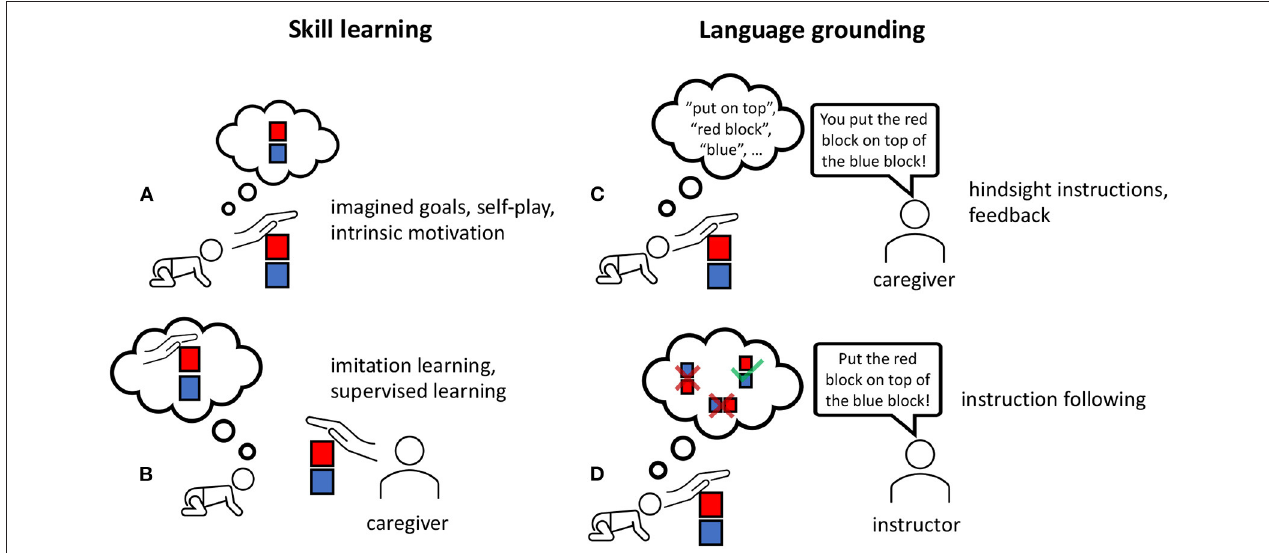
FIGURE 4 | We accentuate the learning phases of current methods (Akakzia et al., 2021; Lynch and Sermanet, 2021) that have a grounded language acquisition by first learning behaviors/skills (A,B) —be it via imitation learning or intrinsic motivation—and following this, ground language in actions by receiving instructions or feedback from a caregiver (C,D)